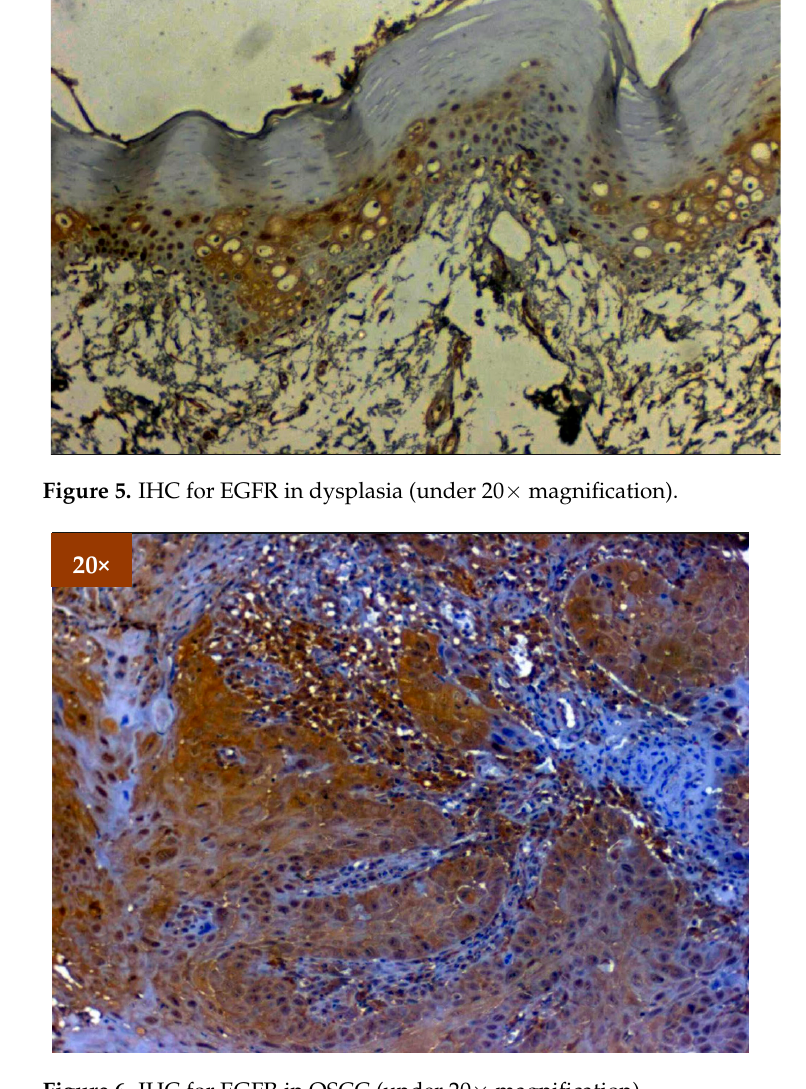
Figure 6. IHC for EGFR in OSCC (under 20× magnification) .